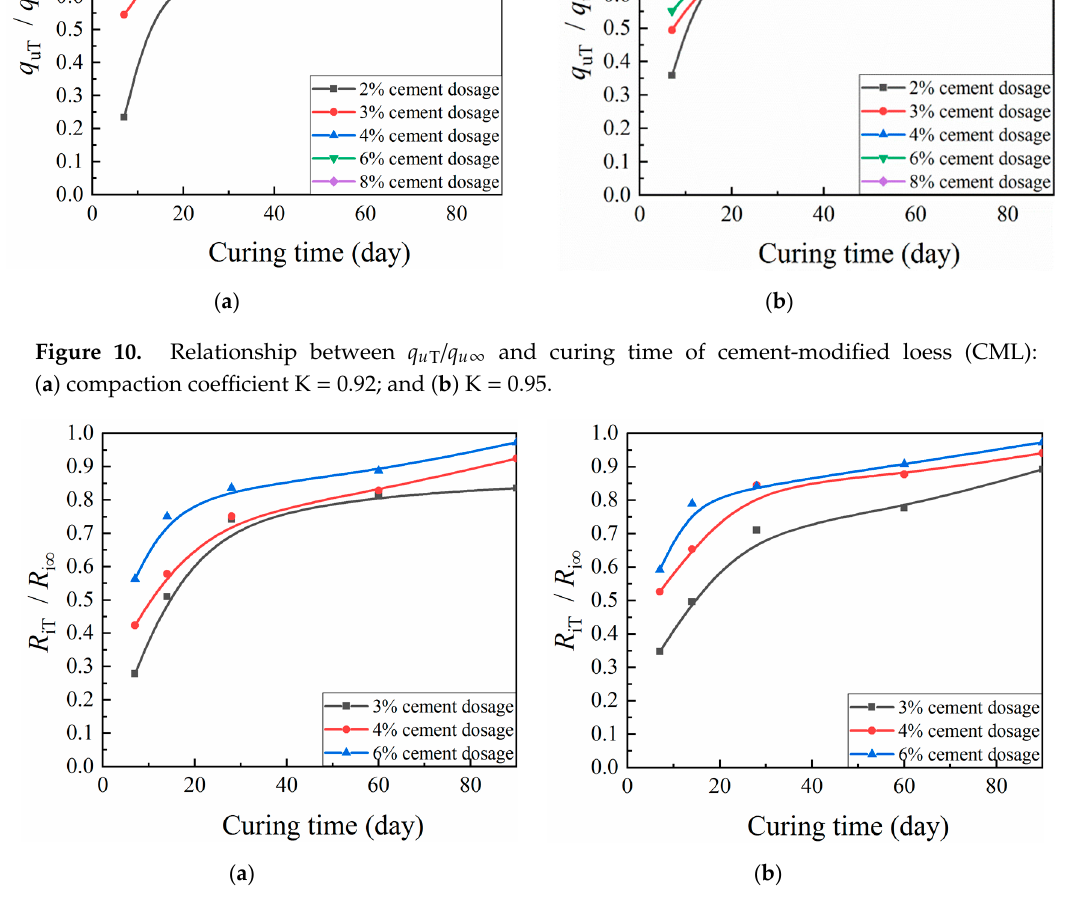
Figure 11. Relationship between R iT / R i ∞ and curing time of cement-modified loess (CML): ( a ) compaction coefficient K = 0.92; and ( b ) K = 0.95.